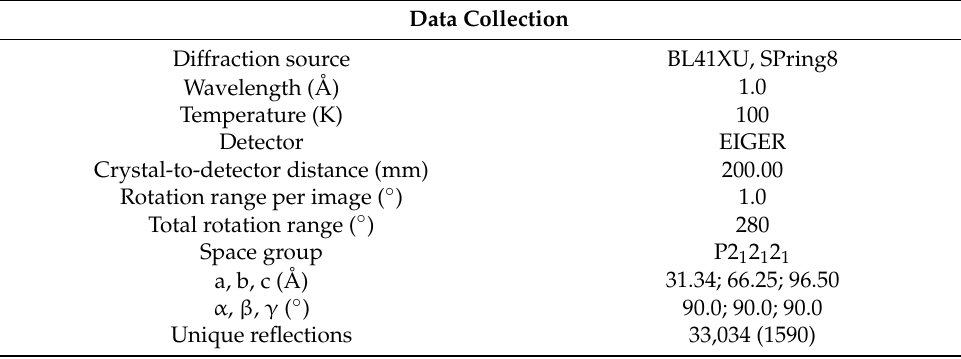
Table 4. Data collection, processing, and